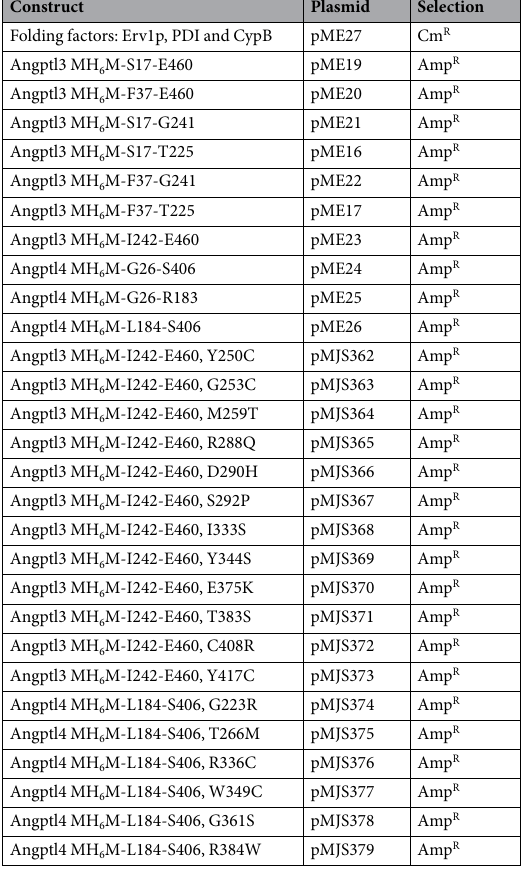
Table 2. Plasmids used in this study. Selection is indicated by Cm R for chloramphenicol resistance and Amp R for ampicillin